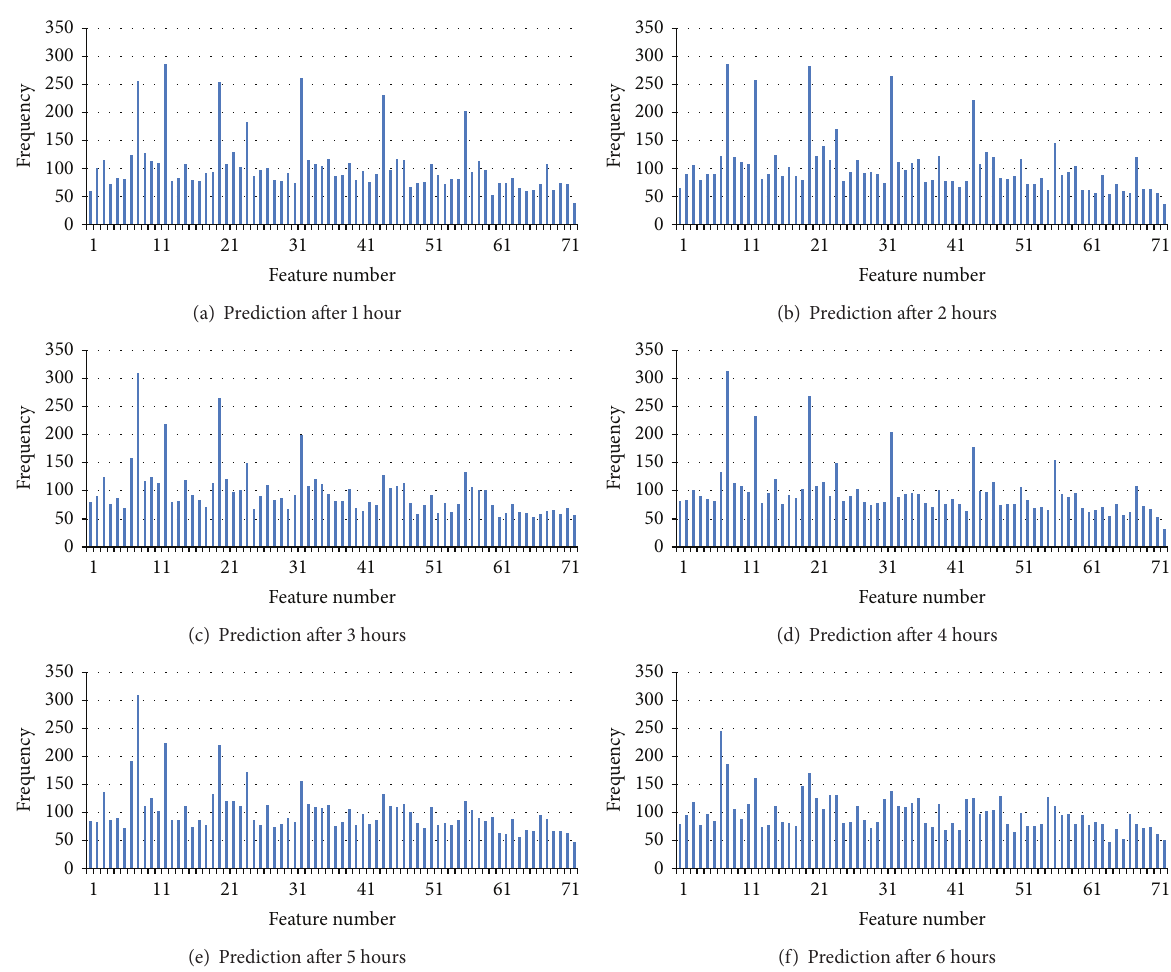
Figure 9: Frequency for selected features after from 1 to 6